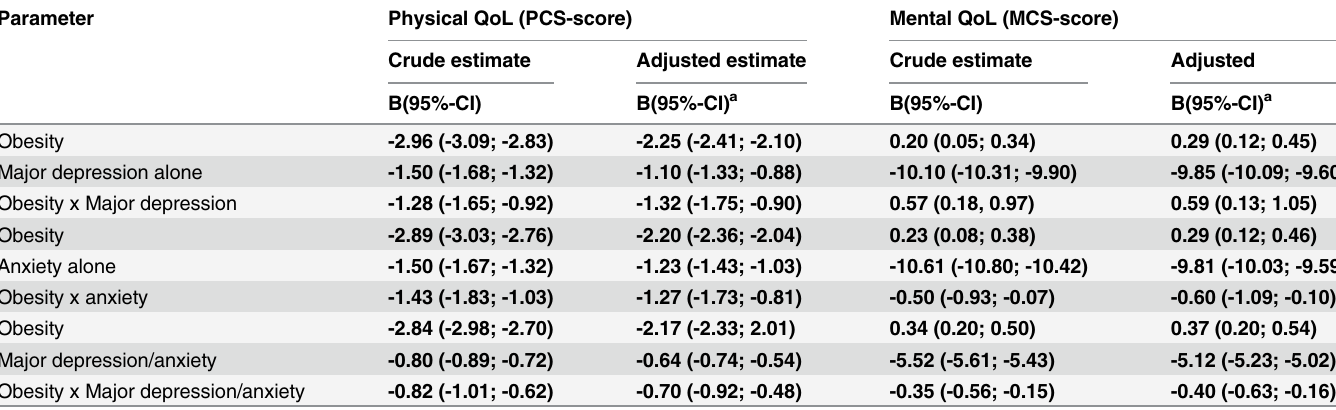
Table 3. The separate association of obesity, major depression/anxiety and their interactions with physical and mental quality of life.